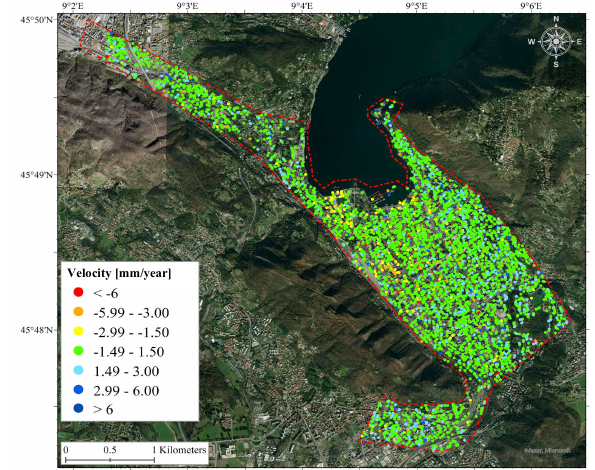
Figure 4. InSAR-derived vertical displacement velocity related